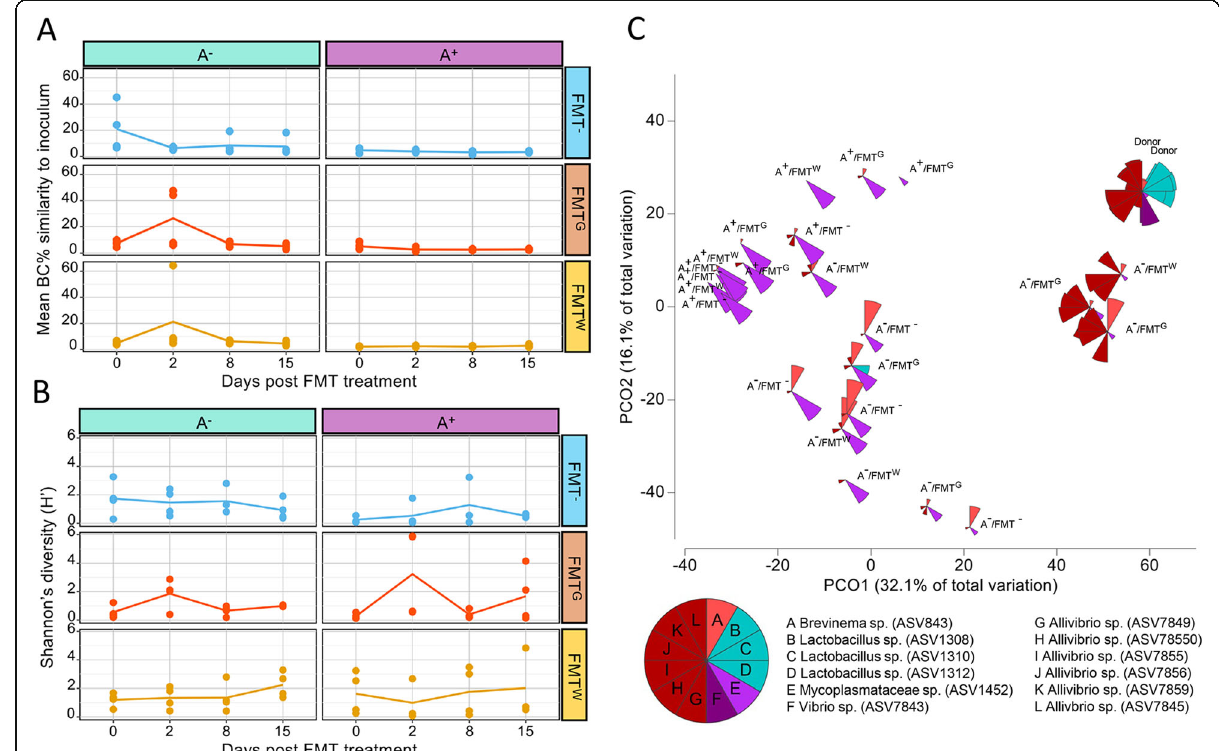
Fig. 5 Impact of FMT on antibiotic perturbed and unperturbed gut microbiota. a - b Line plot presenting the mean Bray-Curtis similarity to the donor inoculum and mean Shannon ’ s index of diversity, respectively, for the different treatment groups; A − /FMT − , A + /FMT − , A − /FMT G , A + /FMT G , A − /FMT W and A + /FMT W over 15 days post FMT (mean from n = 4 fish). c PCoA plot representing Bray-Curtis similarities, comparing global gut bacterial communities between the treated (antibiotic and/or FMT) and untreated fish to the donor inoculum at Day 2 post FMT, with superimposed wedges indicating the relative abundance of the 12 most abundant ASVs in the RNA component of the donor inoculum. Wedge size is proportional to its rank order across all samples, whereby large wedges indicate those ASVs that had the greatest ranked abundance between samples, and the smallest wedges having the lowest ranked abundance between